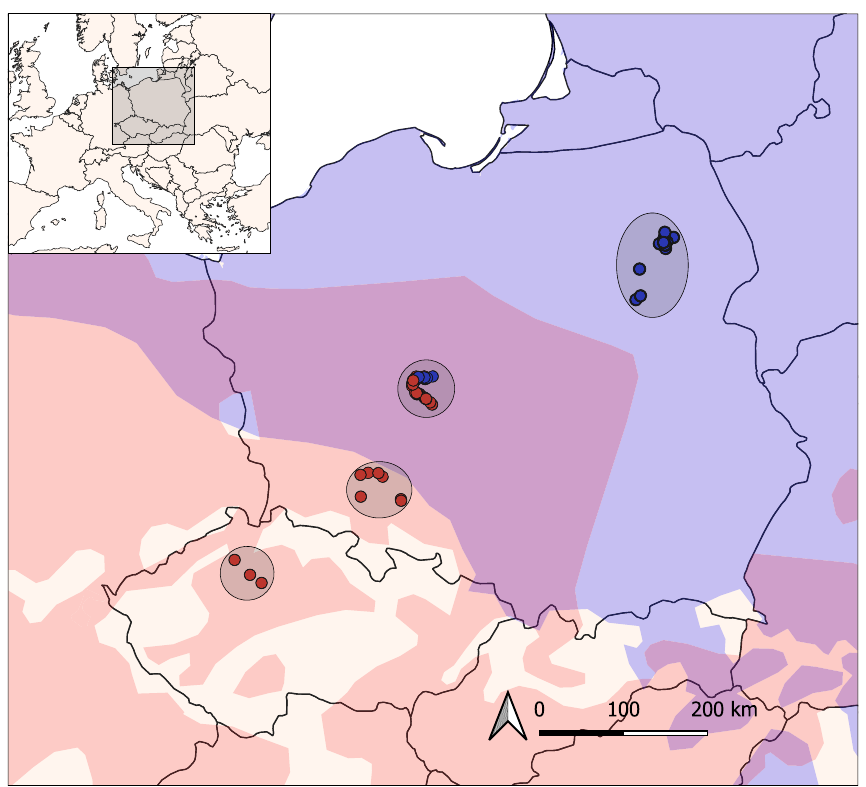
Figure 1. Sampling localities of common nightingales (red) and thrush nightingales (blue) in Poland and the Czech Republic. The distribution areas of common and thrush nightingale are in red and blue, respectively.